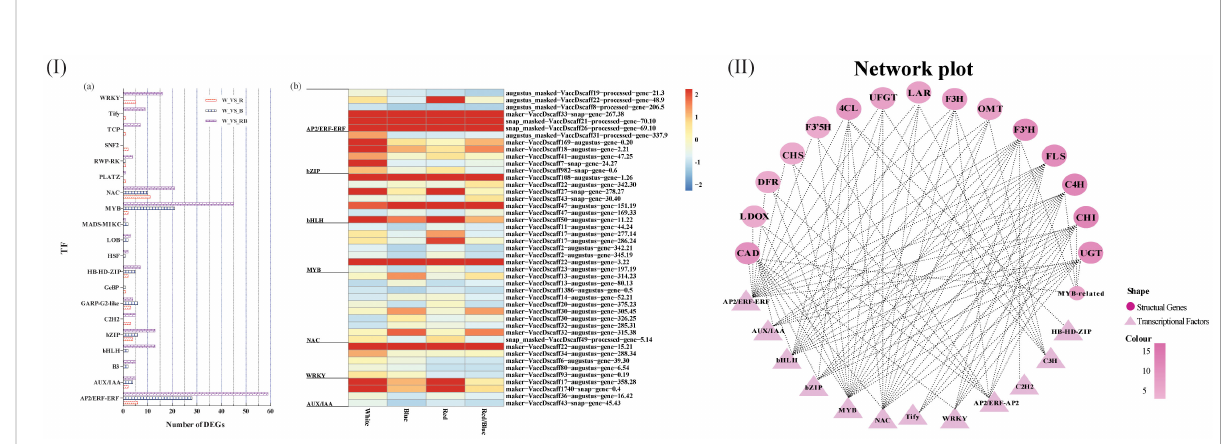
FIGURE 4 Distribution of the differentially expressed transcription factors (TFs) and co-expression networks between candidate genes and transcription factors. (I) Quantitative statistics for the differentially expressed TFs (A) and a heatmap showing the candidate TFs under various light qualities (B) ; (II) Co-expression networks between differentially expressed structural genes involved in the anthocyanin and fl avonoid biosynthetic pathway and differentially expressed TFs under different light